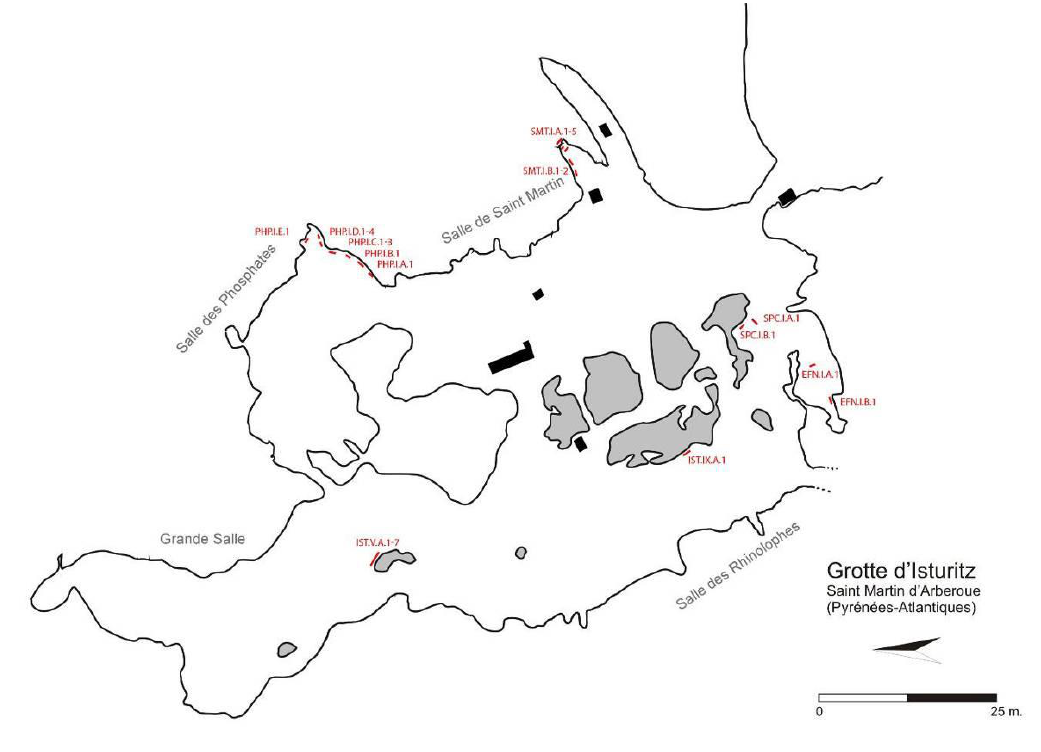
Figure 7. Localization of the graphic units of the Isturitz cave (Diego Garate based on Laplace, 1984)